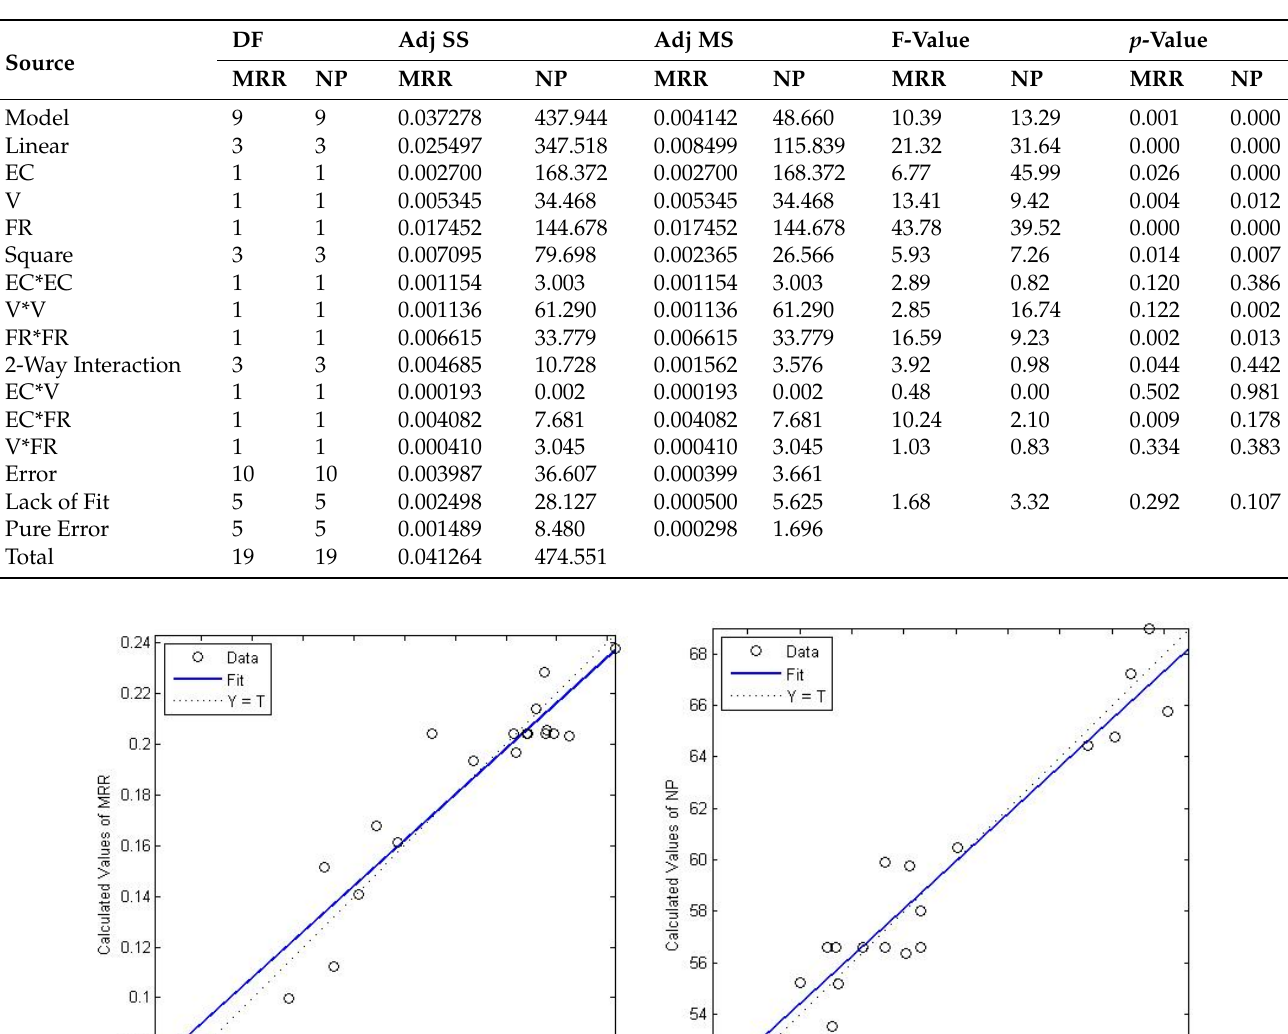
Table 6. Analysis of variance for quadratic models of MRR and NP.